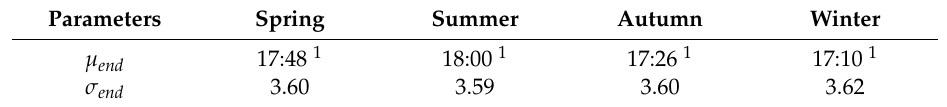
Logarithmic normal probability distribution Exponential probability distribution Cumulative probability of logarithmic normal distribution Cumulative probability of exponential distribution Cumulative probability of initial data